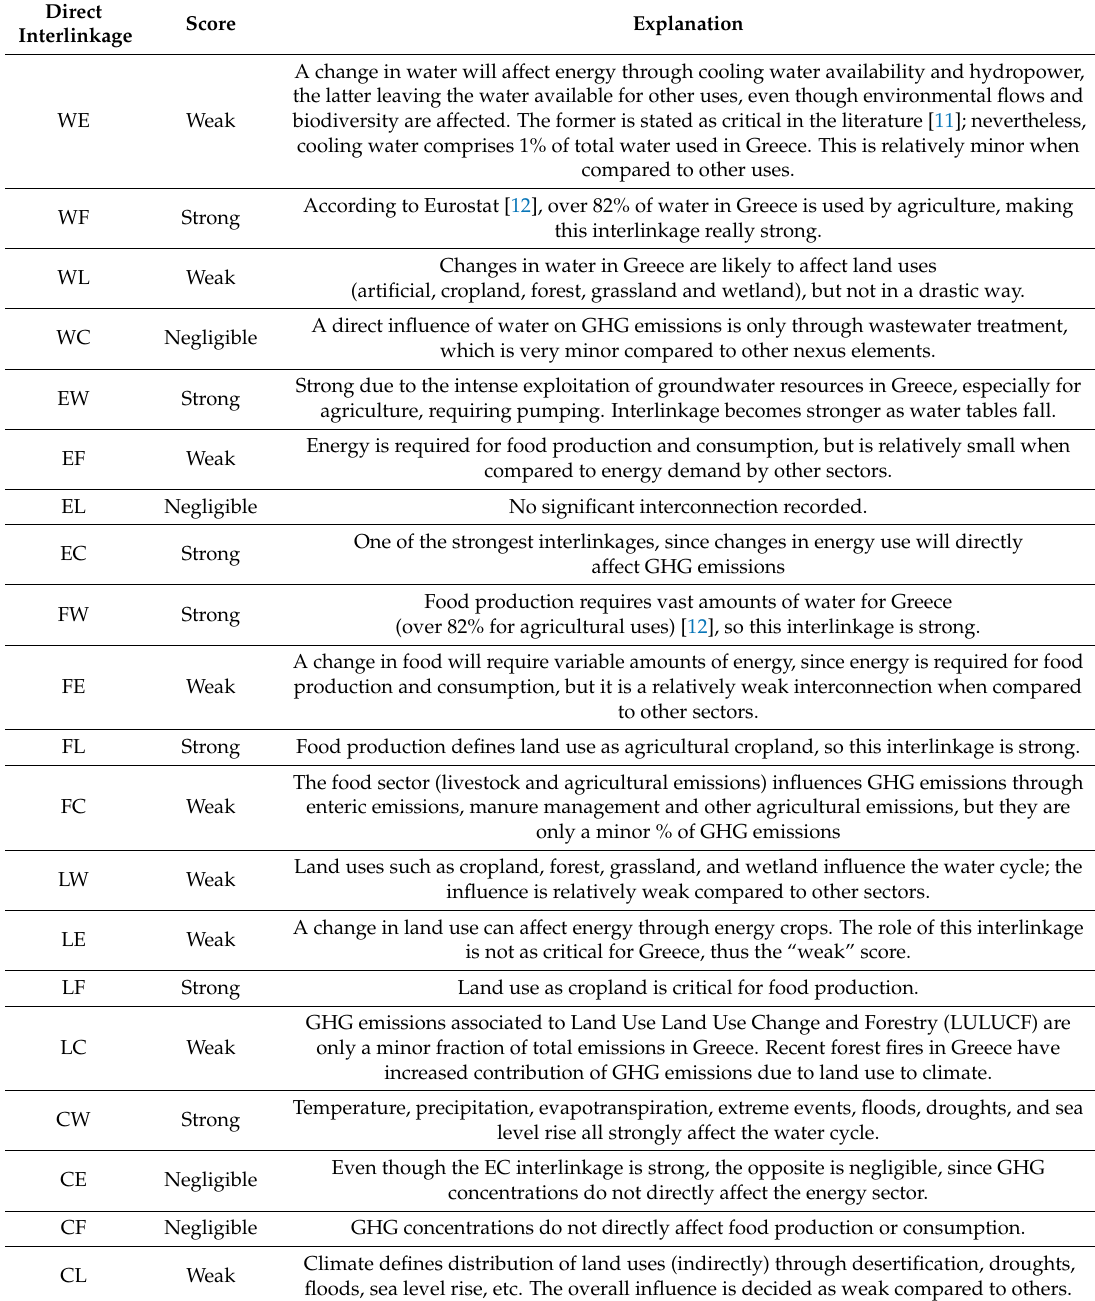
Table 1. Scoring table with interlinkage scores and corresponding explanations for